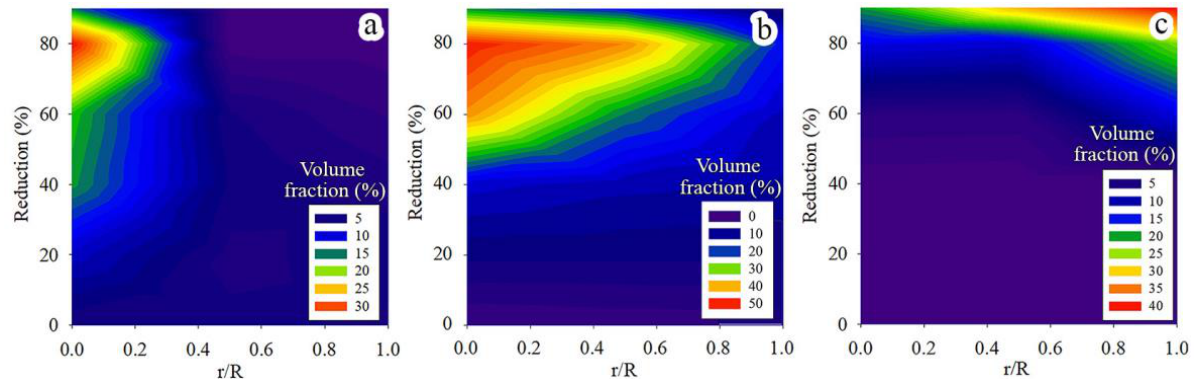
Figure 5. Volume fraction (%) of ( a ) 〈100〉 𝐹𝐶𝐶 -, ( b ) 〈111〉 𝐹𝐶𝐶 -, and ( c ) 〈110〉 𝐵𝐶𝐶 -oriented grains Figure 5. Volume fraction (%) of ( a ) 100 FCC -, ( b ) 111 FCC -, and ( c ) 110 BCC -oriented grains against the against the reduction and radial distance (r/R) — texture maps. reduction and radial distance (r/R)—texture maps.